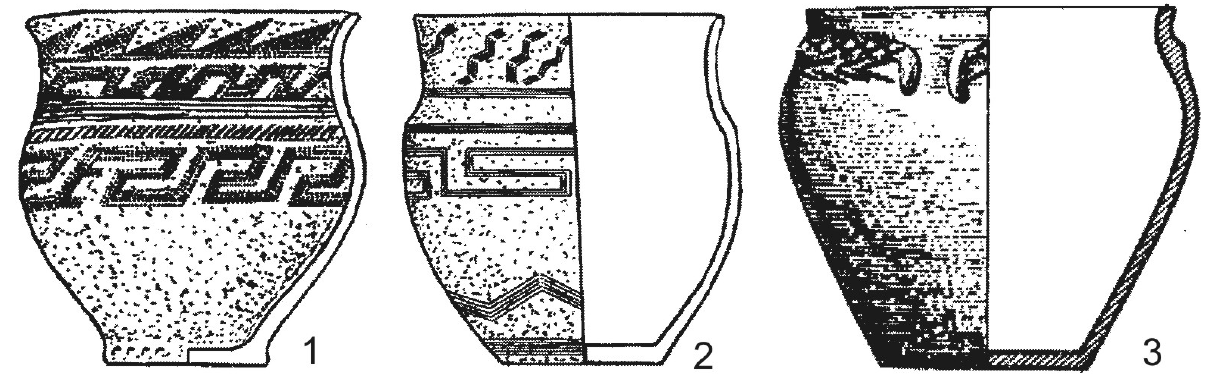
Figure 2: The basic principles of dividing the Andronovo ceramics in early studies: Fyodorovka (1 – cemetery of Putilovskaya Zaimka), Alakul (2 – cemetery of Baklanskoe) and Sargari (3 – Sargari settlement) ceramics (1, 3 – after Zdanovich, 1988; 2 – after Potemkina, 1985).